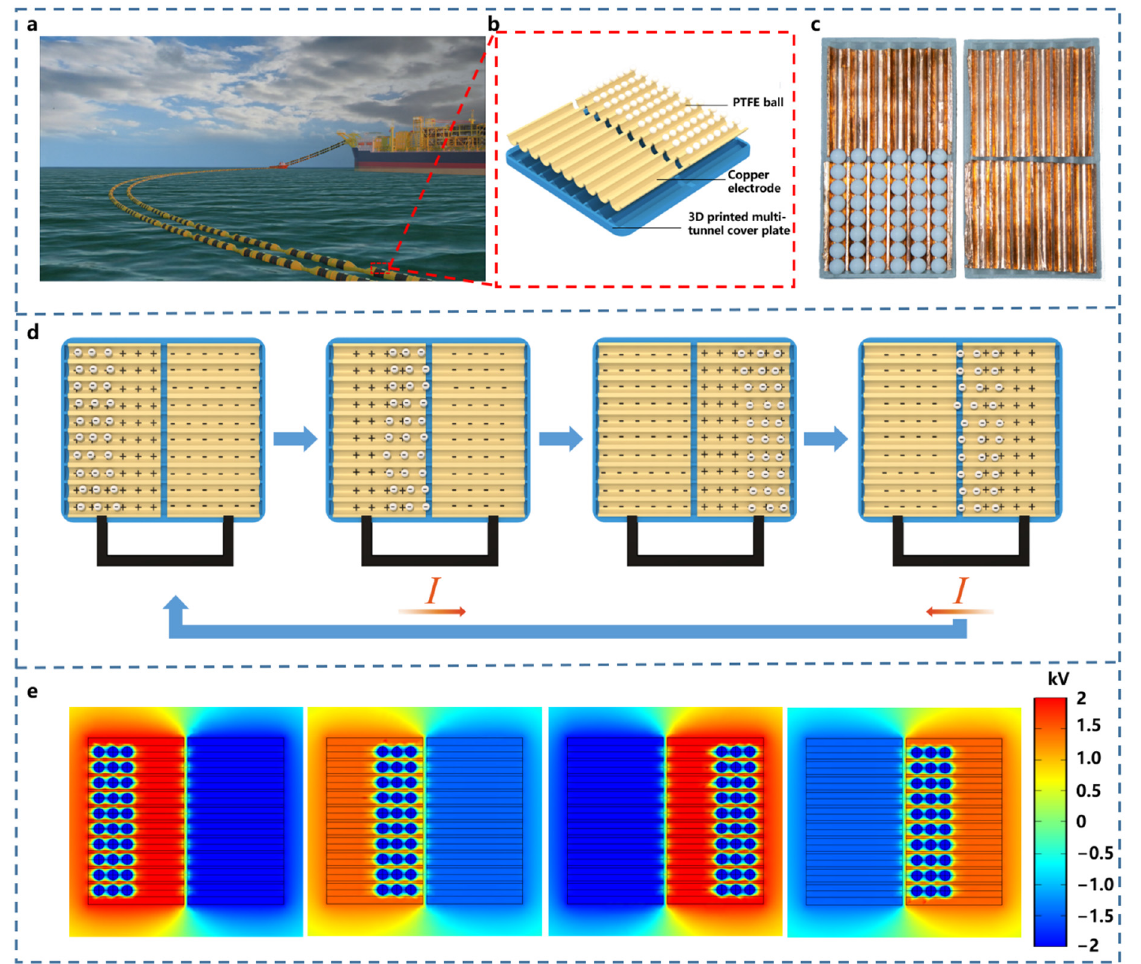
Figure 1. The schematic illustration and working principle of the MT-TENG. ( a ) The schematic diagram of the MT-TENG integrated with floating pipeline. ( b ) The details of the MT-TENG. ( c ) The photograph of the MT-TENG (6-tunnel). ( d ) The working principle of the MT-TENG. ( e ) The corresponding electrical potential distribution simulated by COMSOL Multiphysics.